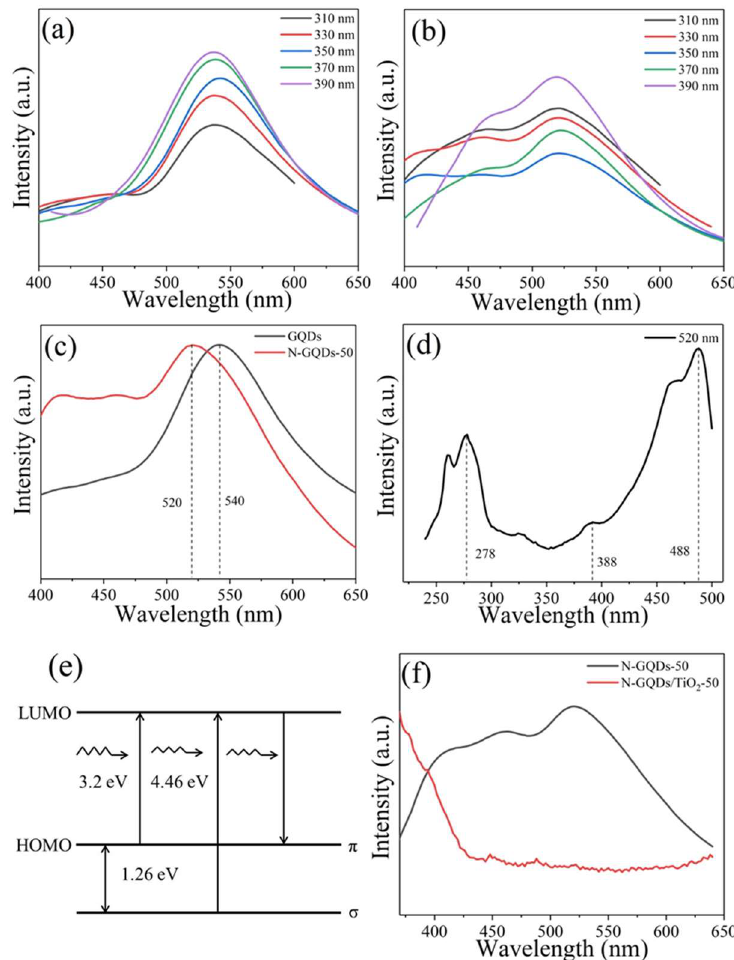
Figure 5. The PL spectra of GQDs ( a ) and N-GQDs-50 ( b ) under excitation with 310–390 nm. ( c ) Comparison of GQDs with N-GQDs under irradiation with 360 nm wavelength. ( d ) PLE spectra of N-QDs-50 when fixing emission wavelength at 520 nm. ( e ) Typical electronic transitions of triple carbenes in the optical spectrum of N-GQDs. ( f ) Comparison of N-GQDs-50 with N-GQDs/TiO 2 -50 under irradiation with 330 nm wavelength.